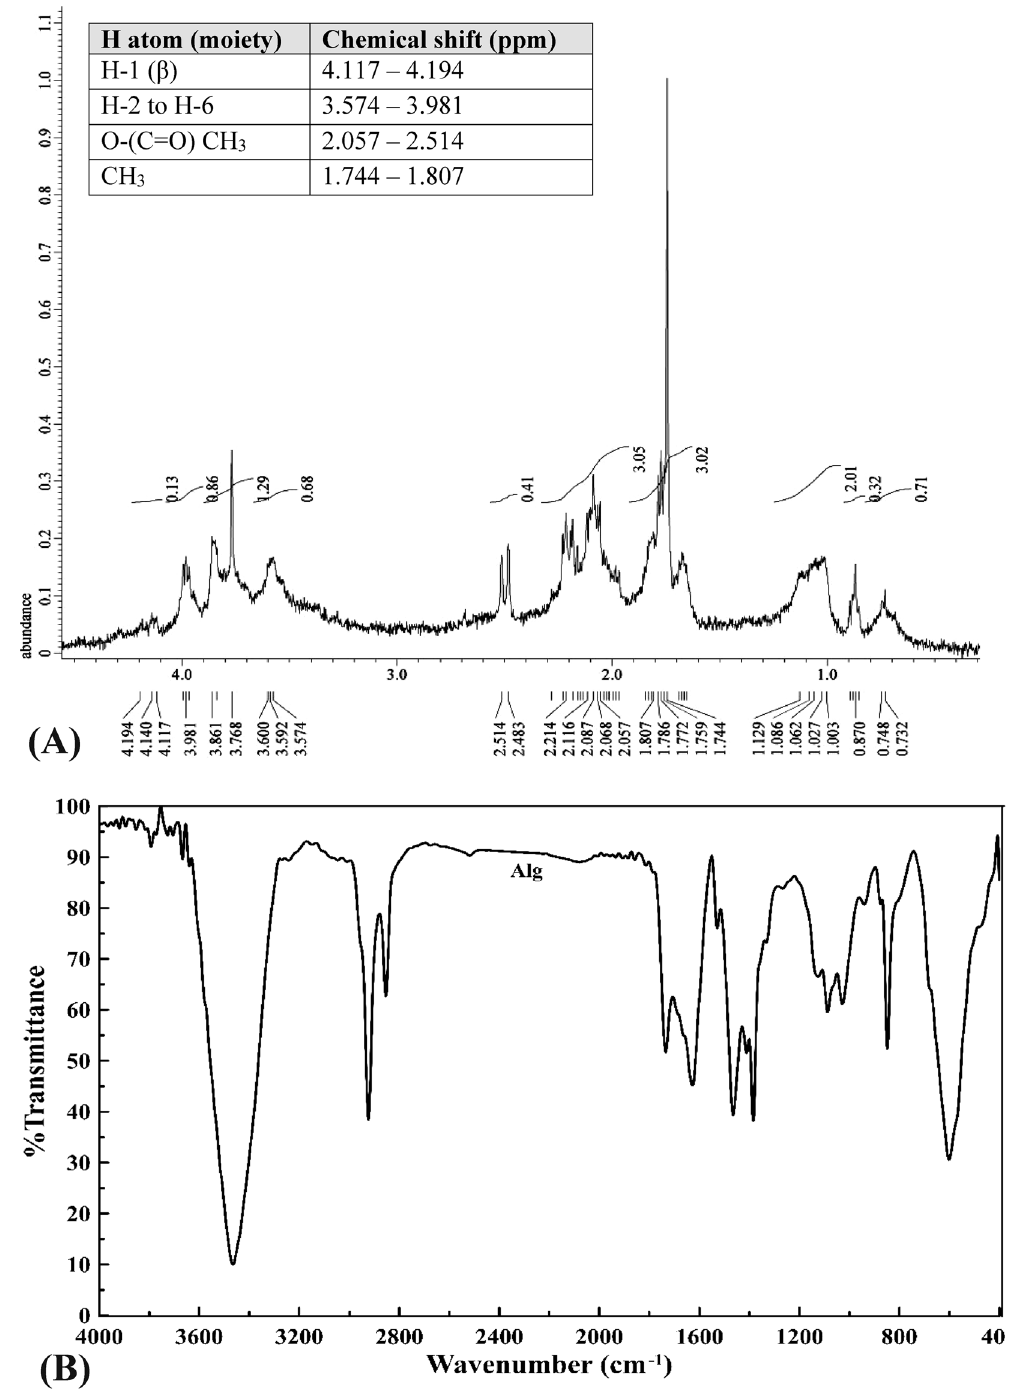
Figure 1. ( A ) NMR of extracted sodium alginate, ( B ) FTIR analysis of sodium